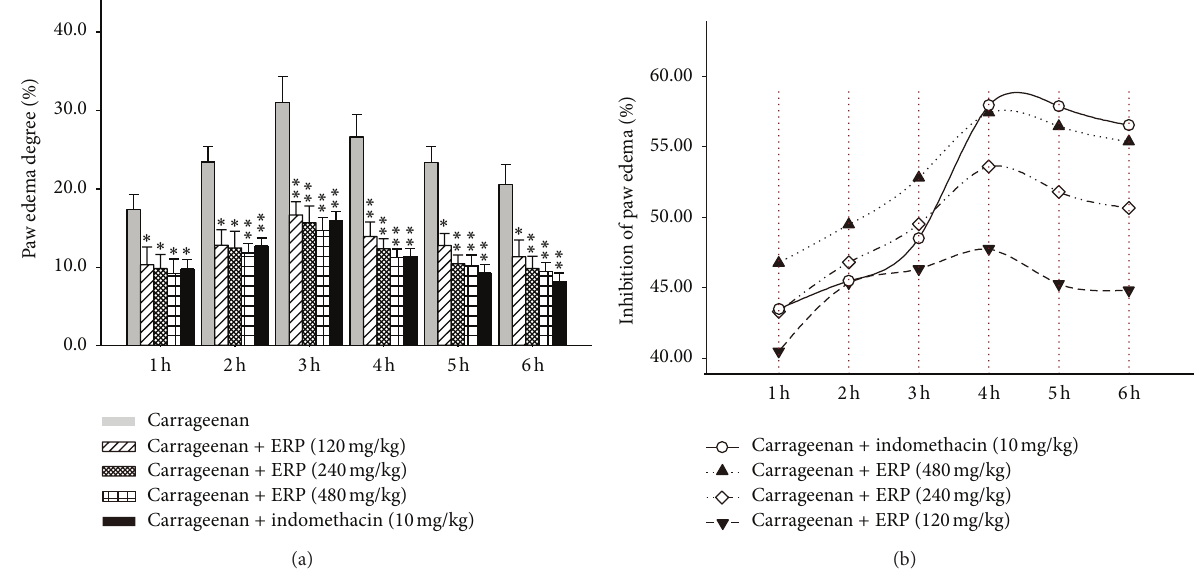
Figure 3: Inhibitory effect of ERP on the carrageenan-induced mouse paw edema. (a) Paw edema degree was represented as the mean ± S.E.M. ( 𝑛 = 10 ). (b) Suppression of paw edema (%) was represented as the ratio of the mean paw size increase of drug treatment group (%) on that of the carrageenan-control group (%). ∗ 𝑃 < 0.05 and ∗∗ 𝑃 < 0.01 compared to the carrageenan-control